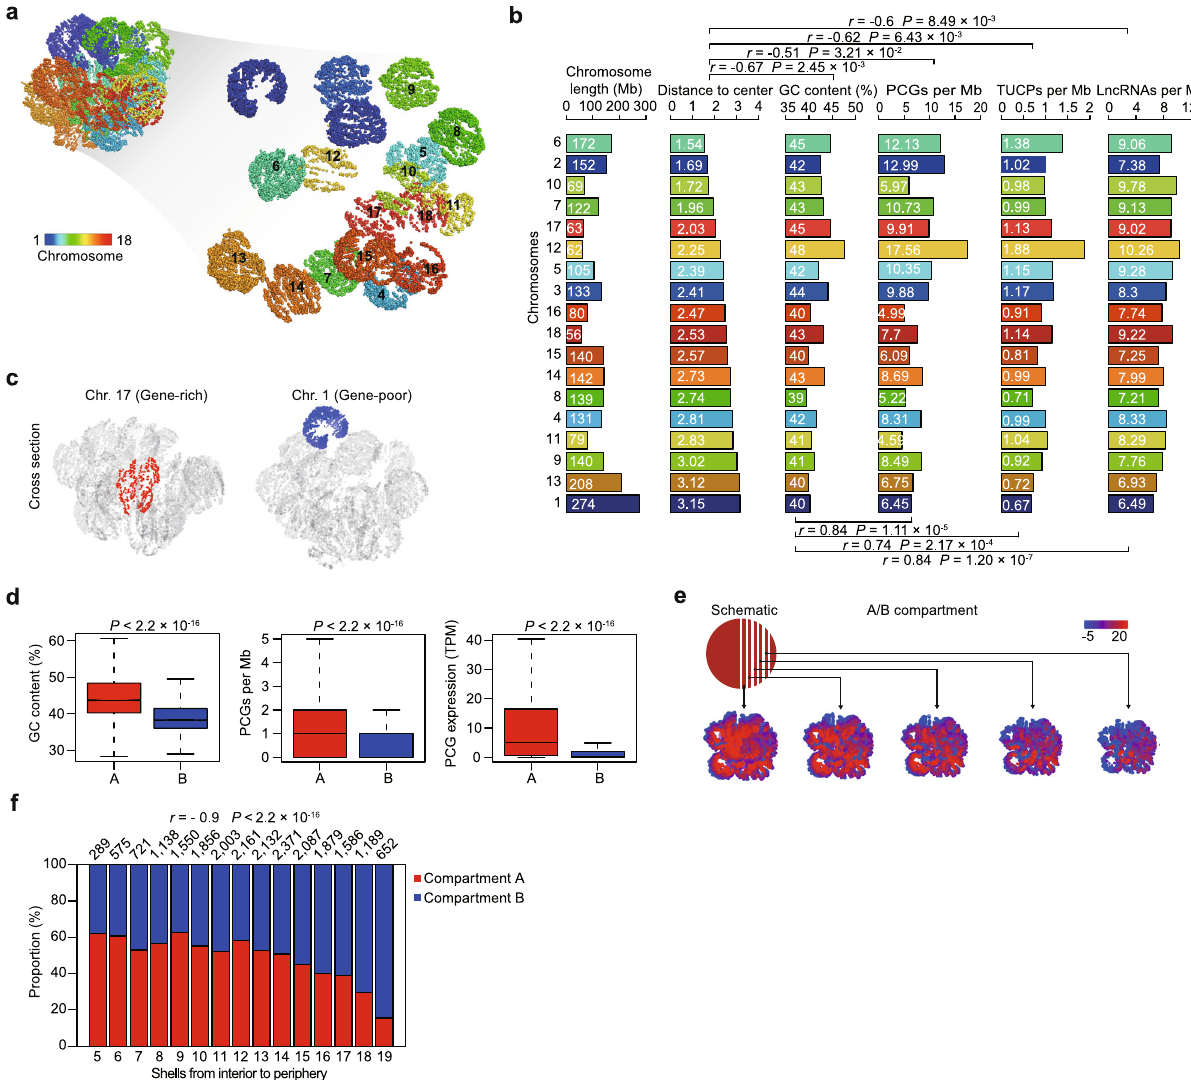
Fig. 2 Transcriptional features in the nuclear space. a 3D genome structure of the representative subcutaneous AT. Left: whole genome; right: separate chromosomes. X chromosome is excluded from this analysis due to the overriding effect of X-chromosome inactivation. Chromosomes are distinguished by color. Each point represents 100 kb of chromatin. b Bar plot indicating chromosome distances to the nuclear center and sequence features of each chromosome. There was a positive correlation between GC content and gene density for PCGs ( r = 0.84), lncRNAs ( r = 0.74), and TUCPs ( r = 0.84). There was a negative correlation between the distance to the center of nucleus and features, including GC content ( r = − 0.67), PCG density ( r = − 0.51), lncRNA density ( r = − 0.62), and TUCP density ( r = − 0.60). The statistical signi fi cance of the two-sided P value was calculated using hypothesis testing. The chromosomes are ranked by distance from the interior (upper) to the periphery (lower). c Examples of preferential localization in the nucleus for two chromosomes. Gene-rich chromosome 17 preferentially localized to the nuclear interior (left), whereas gene-poor chromosome 1 was consistently observed on the nuclear periphery (right). d Comparison of genomic properties including GC content, PCG density, and PCG expression between compartments A (1105 Mb in length) and B (1161 Mb in length). ( P values determined by two-sided Wilcoxon test). In the boxplot, the internal line indicates the median, the box limits indicate the upper and lower quartiles, and the whiskers extend to 1.5 IQR from the quartiles. GC content: n = 11,060 (A), n = 11,608 (B); PCGs per Mb: n = 11,060 (A), n = 11,608 (B); PCG expression: n = 14,430 (A), n = 4898 (B). e 3D models of the pig genome in SAT. Compartments A/B (at 100 kb resolution) were aggregated in 3D space. The plot was visualized in quintuplicate, with fi ve intersecting sections plotted from the interior regions of the nucleus (left) to the periphery (right) based on distance (schematically depicted in the upper-left inset). Color bar indicated the levels of compartments A/B. f Percentage graph showing trends in the arrangement of the A/B compartments from the interior to the periphery within the nucleus. The nucleus is equally divided into 20 shells based on the distance to the 3D nuclear center. The numerical value above each bar indicates the bin (20 kb in size) number within this shell. There was a negative correlation (Spearman ’ s r = − 0.9, P < 2.2 × 10 − 16 ) between the compartment A proportion and the relative distance to the center of the nucleus. The statistical signi fi cance of the two-sided P value was calculated using hypothesis testing. Shells with fewer than 250 bins were excluded from this analysis and are not shown. Source data are provided as a Source Data fi le.